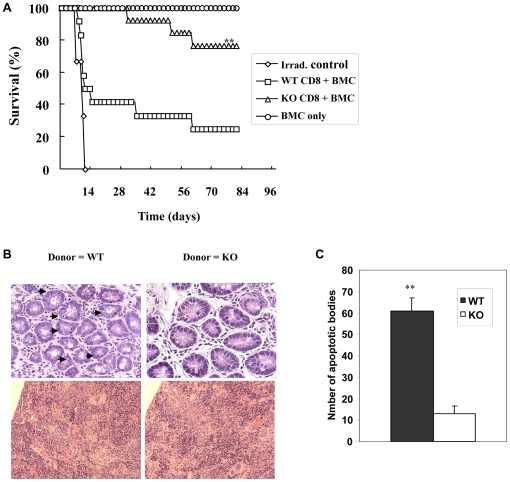
CD103 deficiency attenuates intestinal GVHD mediated by donor CD8 T cells.CD8 T cells primed to A/J alloantigens from either BALB/c-WT (WT) or BALB/c-CD103 KO donors were adoptively transferred into lethally irradiated A/J recipient mice in combination with WT BMC. A. Data shown are survival rates of irradiation control mice (diamonds), recipients of WT BMC plus purified CD8 T cells from either WT (WT CD8, squares, n = 12) or KO donors (KO CD8, triangles, n = 13), and recipients of BMC only (circles, n = 3). These data derive from two separate experiments with similar results. **p-value = 0.003, compared to the survival of hosts receiving WT CD8 T cells (log-rank test). B. H&E sections of the host intestine (upper panel) and spleen (lower panel) taken from recipients of WT or KO CD8 T cells. Arrows indicate apoptotic bodies. C. Mean number of apoptotic bodies per hundred intestinal villi ± SEM in recipients of CD8 T cells from WT donors (WT, closed bar, n = 3) or KO donors (KO, open bar, n = 3). **p<0.01.